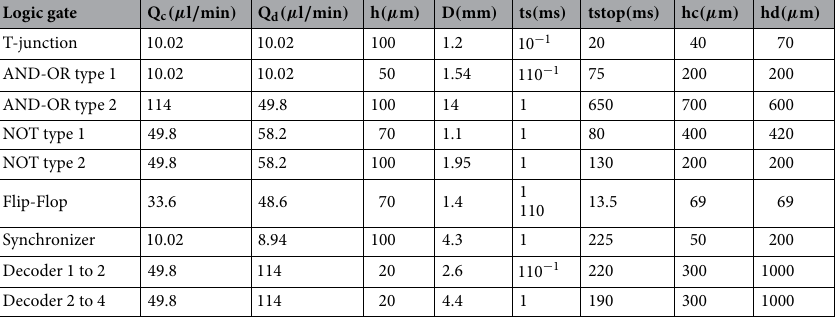
Table 5. The parameters required for simulating the logic